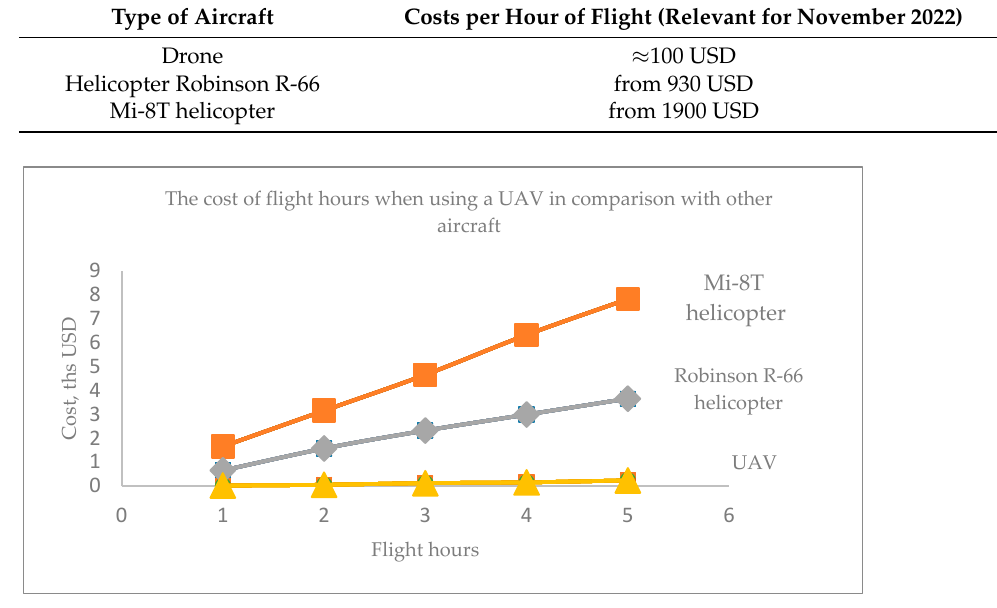
Figure 5. The cost of flight hours when using a UAV in comparison with other aircrafts [51].